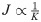
Transforming synaptic strengths J with the square root of the number of incoming synapses per neuron K (the in-degree) upon scaling of network size N changes correlation structure when mean and variance of the input current are maintained.A reference network of 10,000 inhibitory leaky integrate-and-fire neurons is scaled up to 50,000 neurons, fixing the connection probability and adjusting the external Poisson drive to keep the mean and variance of total (external plus internal) inputs fixed. Single-neuron parameters and connection probability are as in Table 2. Delays are 1 ms, mean and standard deviation of total inputs are 15 mV and 10 mV, respectively, and the reference network has J = 0.1 mV. Each network is simulated for 50 s. A Onset of oscillations induced by scaling of network size N, visualized by changes in the poles z of the covariance function in the frequency domain. Re(z) determines the frequency of oscillations and Im(z) their damping, such that -Im(z) > 0 means that small deviations from the fixed-point activity of the network grow with time [cf. Eq (76)]. The transformation J∝1K preserves the poles, while J∝1K induces a Hopf bifurcation so that the scaled network is outside the linearly stable regime. B Covariance in the network where coupling strength J is scaled with the in-degree K matches that in the reference network, whereas large oscillations appear in the network scaled with K. Colors as in A.